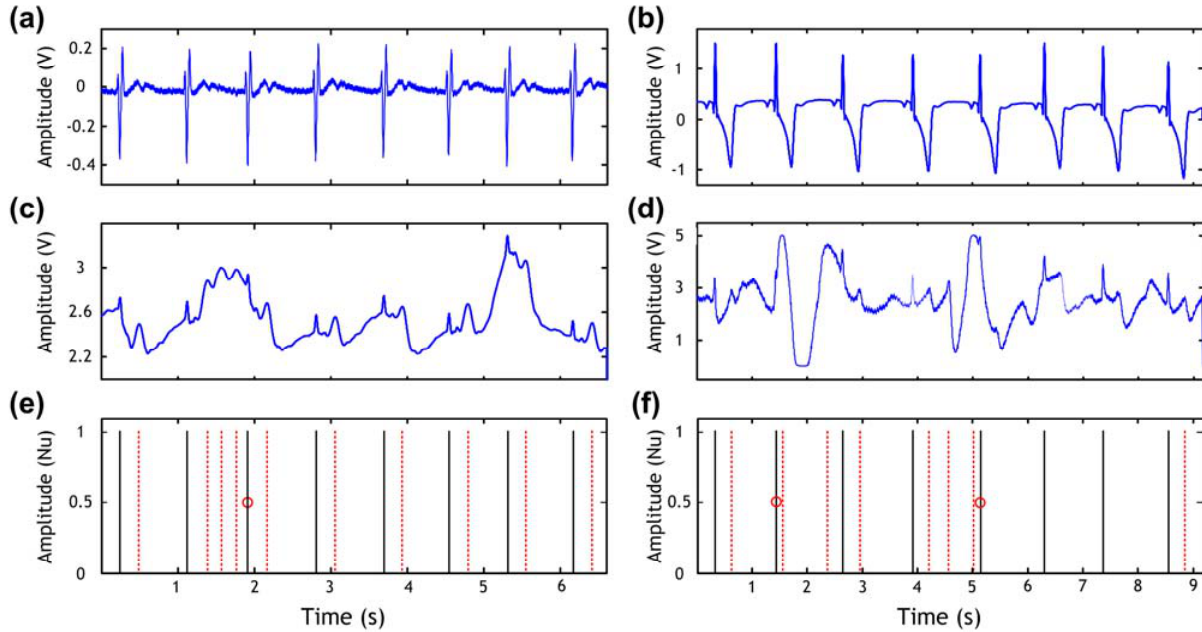
Figure 7. ECG detected by commercial three leads ECG device in (a) Example 1 and (b) Example 2. (c) Heartbeats detected by the PVDF sensor corresponding to Example 1 in (a). (d) ECG signal detected by the conductive fabric sensor corresponding to Example 2 in (b); (e) and (f) show the true peaks expressed by solid lines and misdetections expressed by dotted lines, and the missed peaks marked by circles corresponding to (c) and (d) respectively. Nu expresses normalized